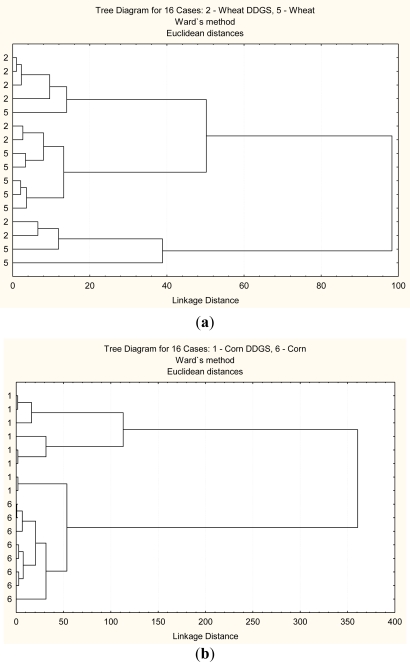
Multivariate molecular spectral analyses of the co-products from bioethanol production at the total carbohydrate region (ca. 1187–950 cm−1): CLA cluster analyses of molecular spectrum (Distance method: Euclidean; Cluster method: Ward’s algorithm); Principal component analysis (PCA) analyses of molecular mid-IR spectrum. (a,c) wheat DDGS (code 2) vs. wheat (code 5); (b,d) corn DDGS (code 1) vs. corn (code 6). (a) Cluster analysis: molecular structure of wheat vs. molecular structure of wheat DDGS; (b) Cluster analysis: molecular structure of corn vs. molecular structure of corn; (c) PCA: molecular structure of wheat vs. molecular structure of wheat DDGS. 1st vs. 2nd principal component; (d) PCA: molecular structure of corn vs. molecular structure of corn DDGS. 1st vs. 2nd principal component.